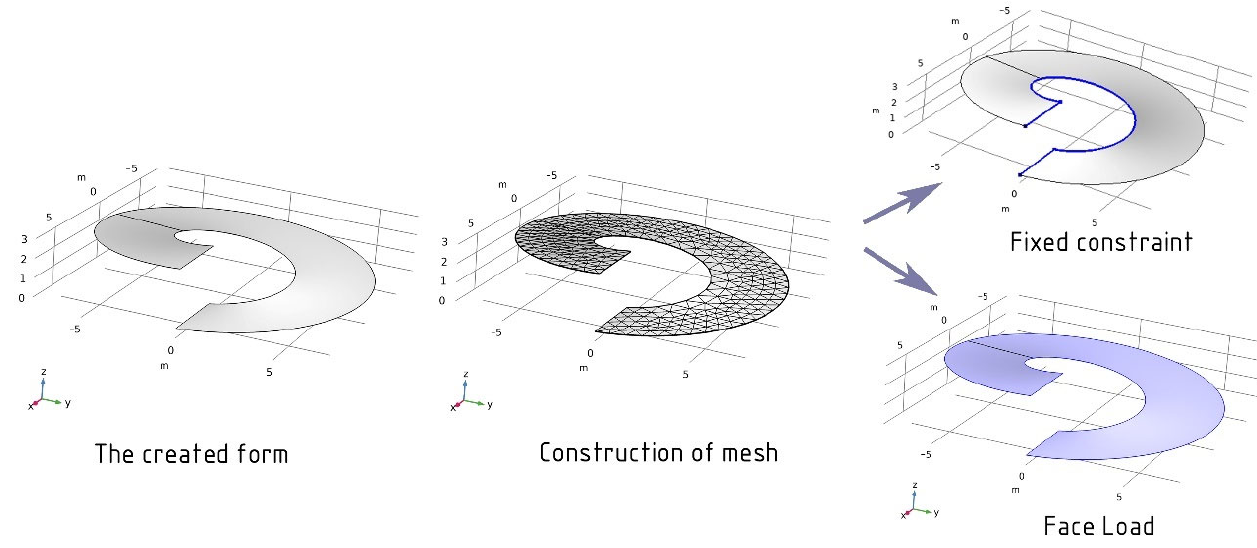
Figure 7. Scheme of preparation of the sphere shell for calculation.